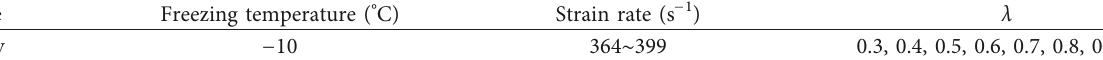
Figure 3: Modified SHPB equipment [18, 19]. Table 3: SHPB test design of artificial frozen silty clay.